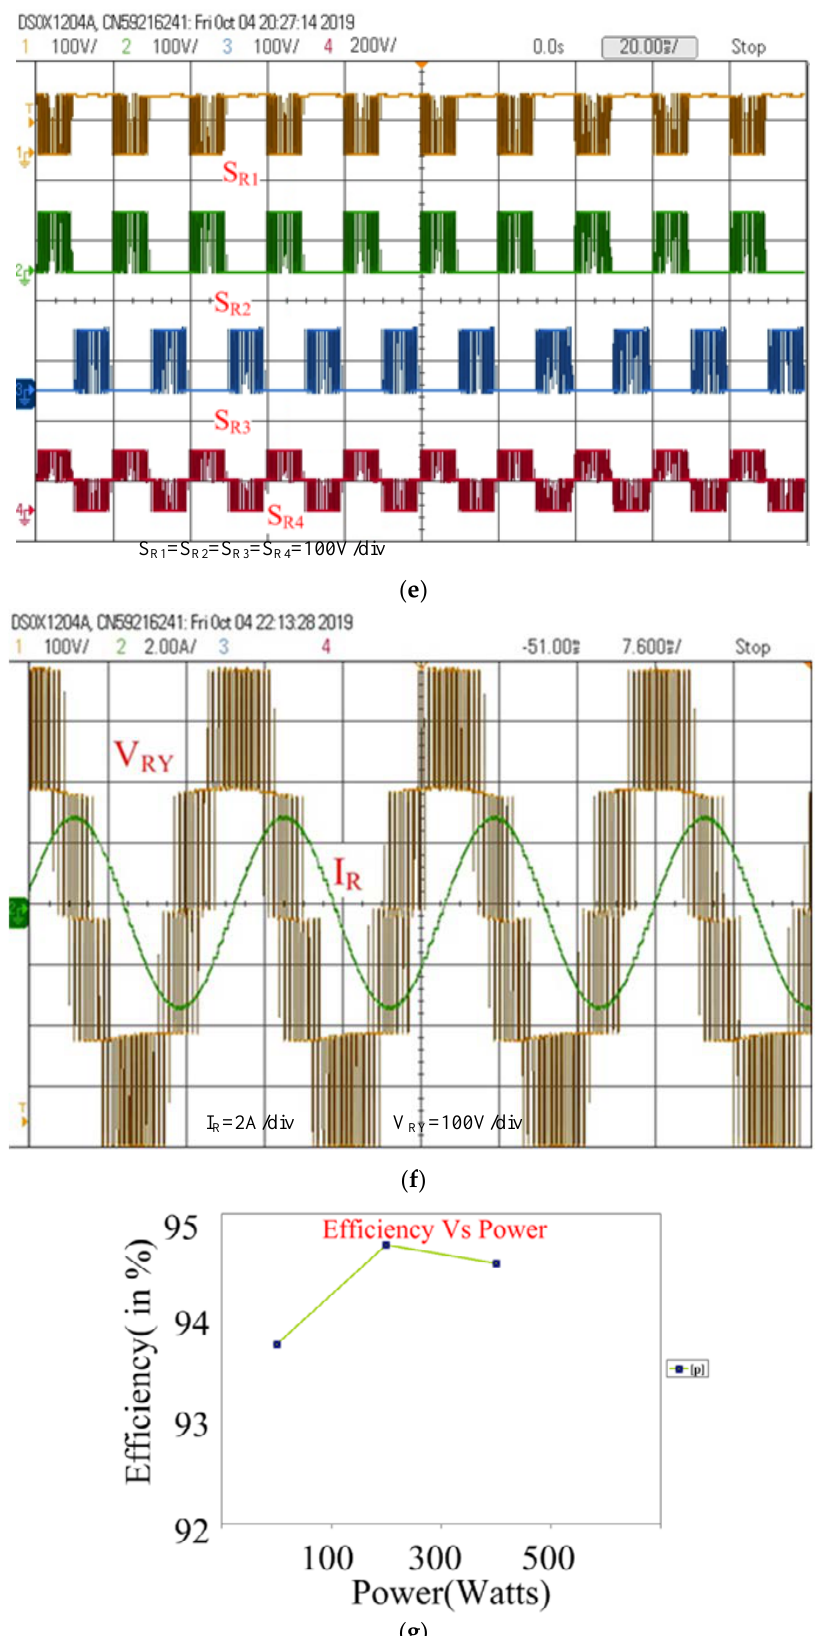
Figure 7. Experimental results. ( a ) Pole voltage; ( b ) Line voltage; ( c ) Voltage ripple across the capacitors; ( d ) Line current; ( e ) Voltage across switches; ( f ) Current and voltage on phase R; ( g ) Power versus efficiency